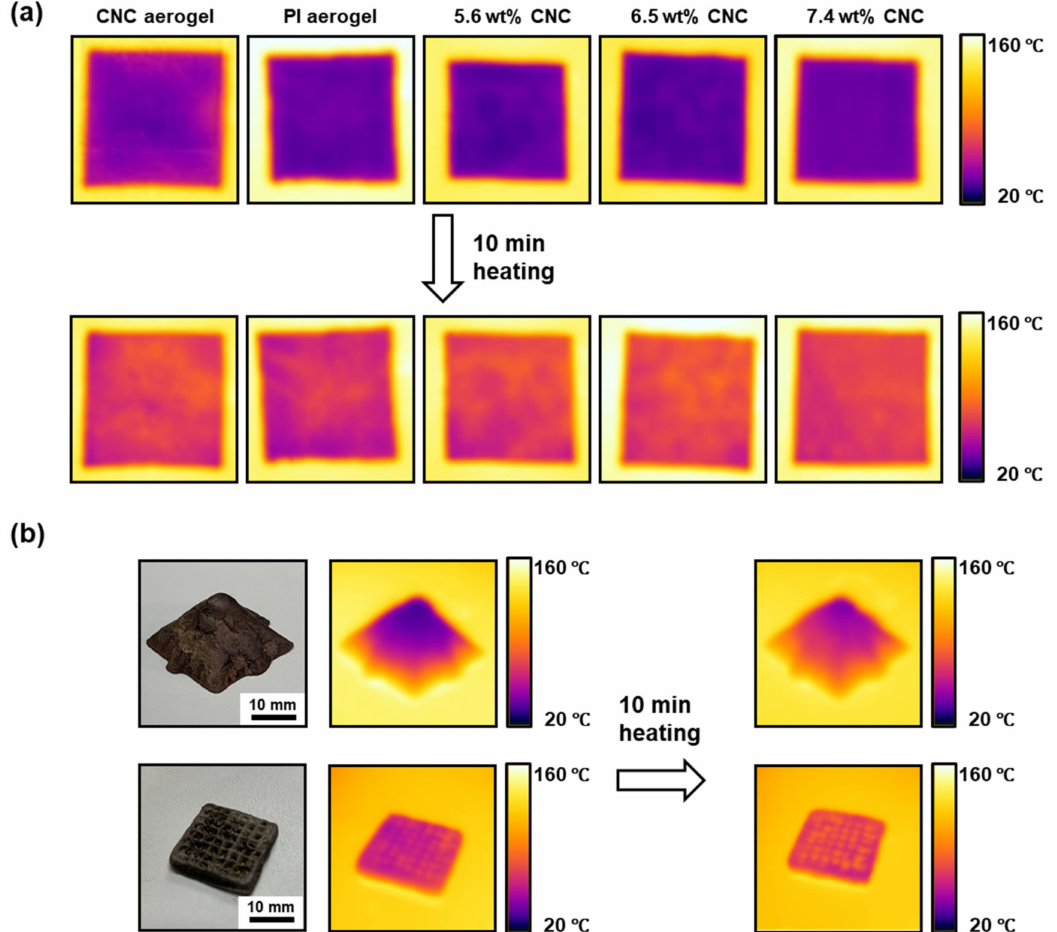
Figure 8. The thermal insulation performance of aerogels. ( a ) Infrared images of pure CNC aerogel, pure PI aerogel, and PI/CNC aerogels with different concentrations of CNCs. The sample size was 2.8 × 2.8 × 0.4 cm 3 . ( b ) 3D printed pyramid and grid of PI/CNC